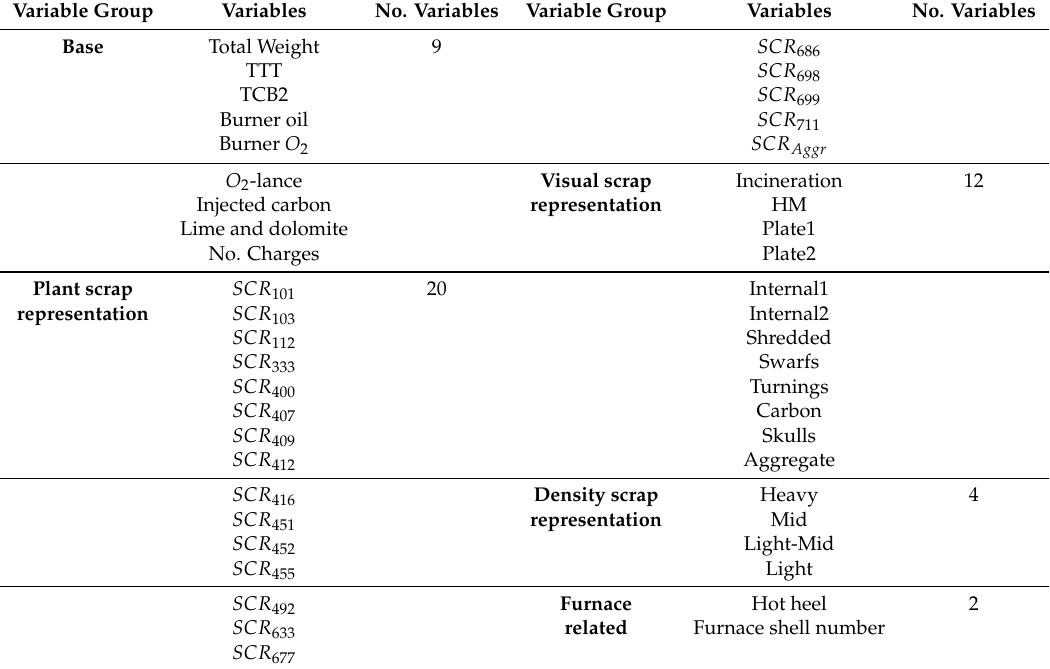
Table 4. Input variables for each variable group. There is a total of 48 input